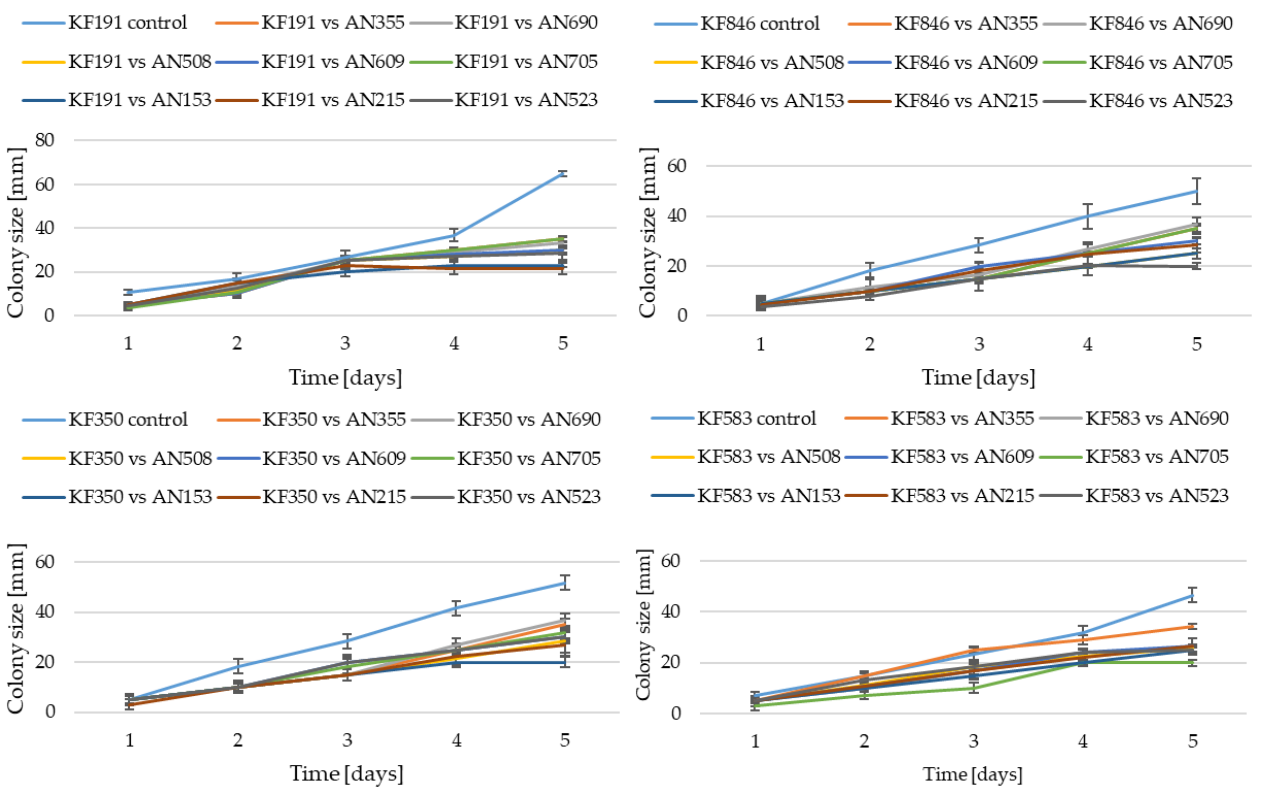
Figure 2. The inhibitory effect of antagonistic Trichoderma isolates on the growth rate of Fusarium spp. on PDA. The strain designations are the same as in Figure 1. Table 2. The assessment of the interaction between Trichoderma vs. Fusarium colonies after 5 days of co-culturing on PDA